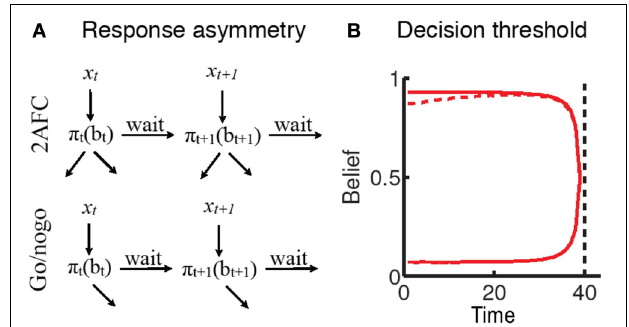
FIGURE 3 | Rational impatience in the go/nogo task (Shenoy and Yu, 2012). (A) The rational decision-making framework suggests that choices unfold over time as sensory uncertainty is resolved. For a forced -choice decision-making task, all stimuli eventually result in responses that terminate the trial. For a go/nogo task, the go stimulus requires a go response that terminates the trial; however, the nogo stimulus requires withholding response until the end of the trial; where ( x i ) and ( y i ) are the (cid:2) is the decision policy sensory inputs incorporated into beliefs (b i ), and relating specific beliefs to a choice between actions (a1 ,..., an, wait). (B) The asymmetry is reflected in the decision thresholds for the two tasks: go-nogo response threshold (dashed red line) is initially lower than forced-choice threshold (solid red line), reflecting the tradeoff between go errors and opportunity cost (see